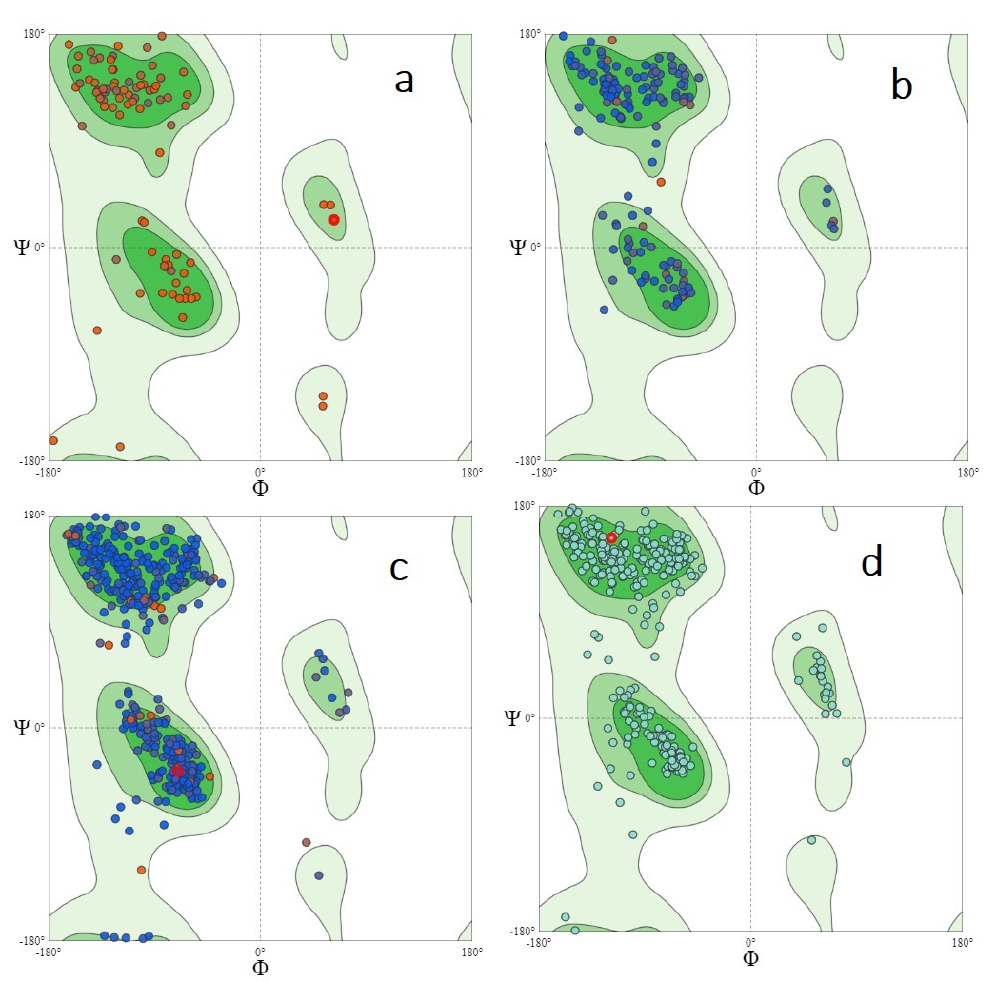
Figure A1. Ramachandran plot of the modeled structures. Ramachandran plot of the modeled structures: ( a ) membrane protease; ( b ) spike receptor-binding domain; ( c ) nonstructural protein 14; ( d ) transmembrane protease, serine 2. General glycine/pre-proline/proline favoured regions; General glycine/pre-proline/proline allowed regions; Glycine favoured regions; Glycine allowed regions.